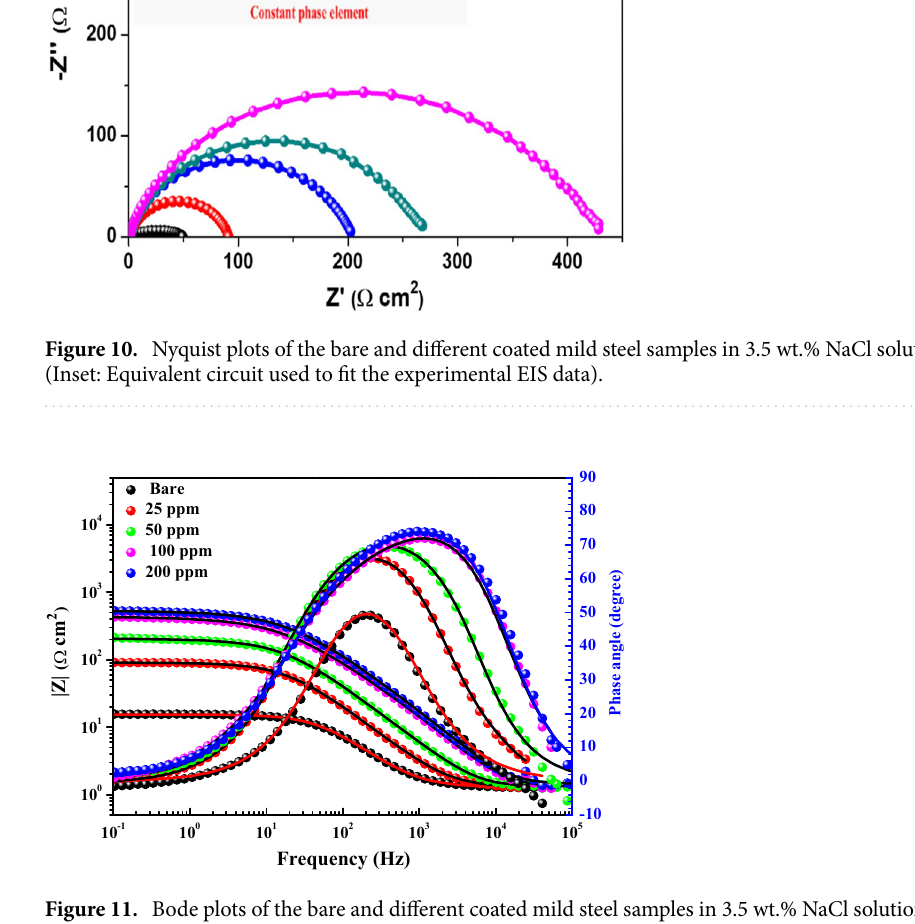
Figure 11. Bode plots of the bare and different coated mild steel samples in 3.5 wt.% NaCl solution at 25